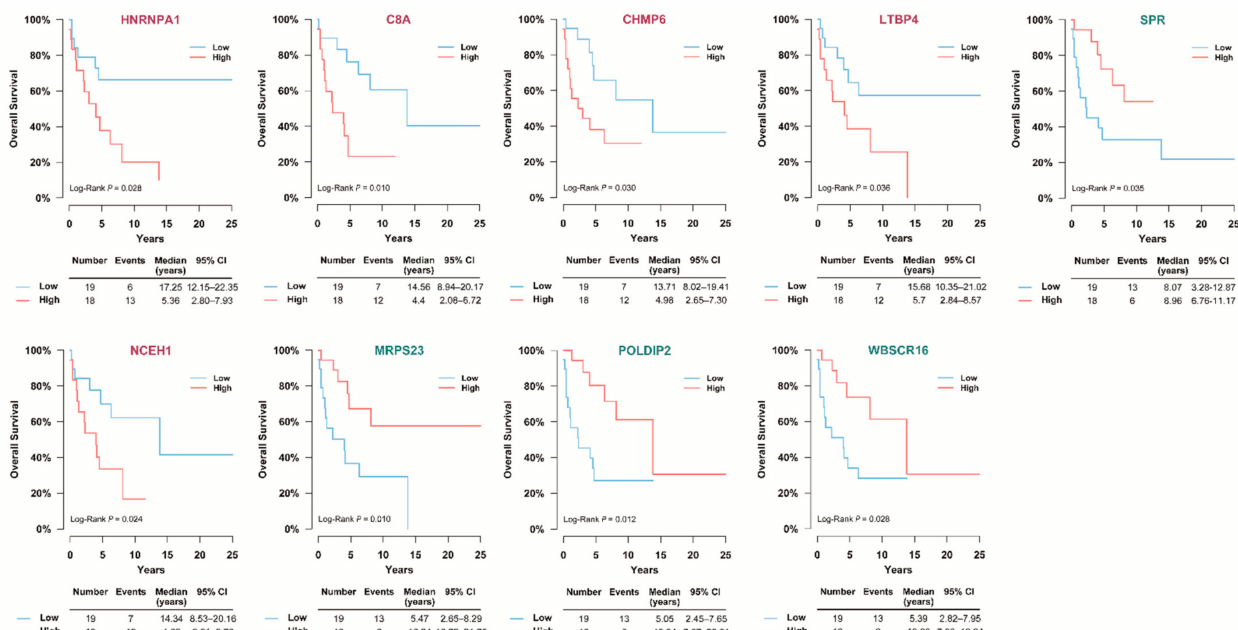
Figure 5. Kaplan–Meier analyses of significant DEPs in SNUH cohort. When Kaplan–Meier analyses were performed on the featured proteins, nine proteins with significant differences were identified. It was analyzed by dividing it into low and high groups based on the median value. When comparing benign adrenal adenomas with ACC, the high expression of HNRNPA1 was associated with poor overall survival. When comparing stage 1–2 and stage 3–4 ACCs, high expressions of C8A, CHMP6, and LTBP4 and low expression of SPR were associated with poor overall survival. In addition, when comparing stages 1–3 and stage 4 ACCs, high expression of NCEH1 and low expressions of MRPS23, POLDIP2, and WBSCR16 were associated with poor overall survival. ACC—adrenal cortical carcinoma; C8A—complement C8